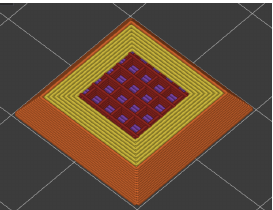
Figure 3. Exemplary illustration of a slice through the tool paths and naming conventions for sample 2 shown in PrusaSlicer software, 8 outer walls in red/orange for the outermost wall, purple for the solid bottom layer and red the hatched infill every 4µm. The shown sliced pyramid is scaled by a